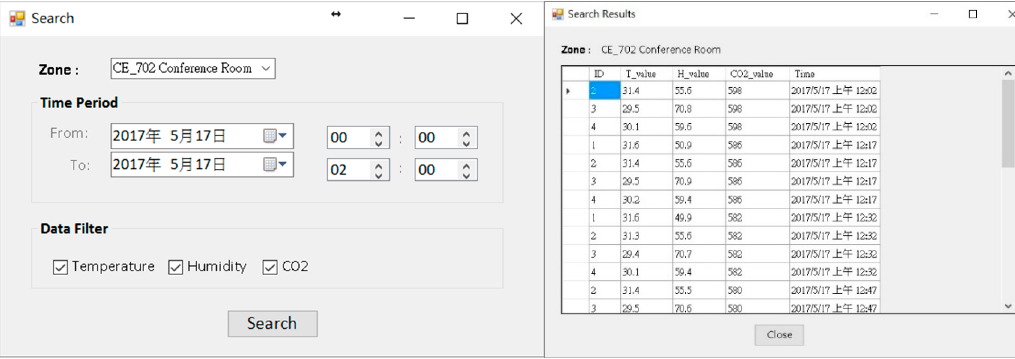
Figure 9. Historical data search function.